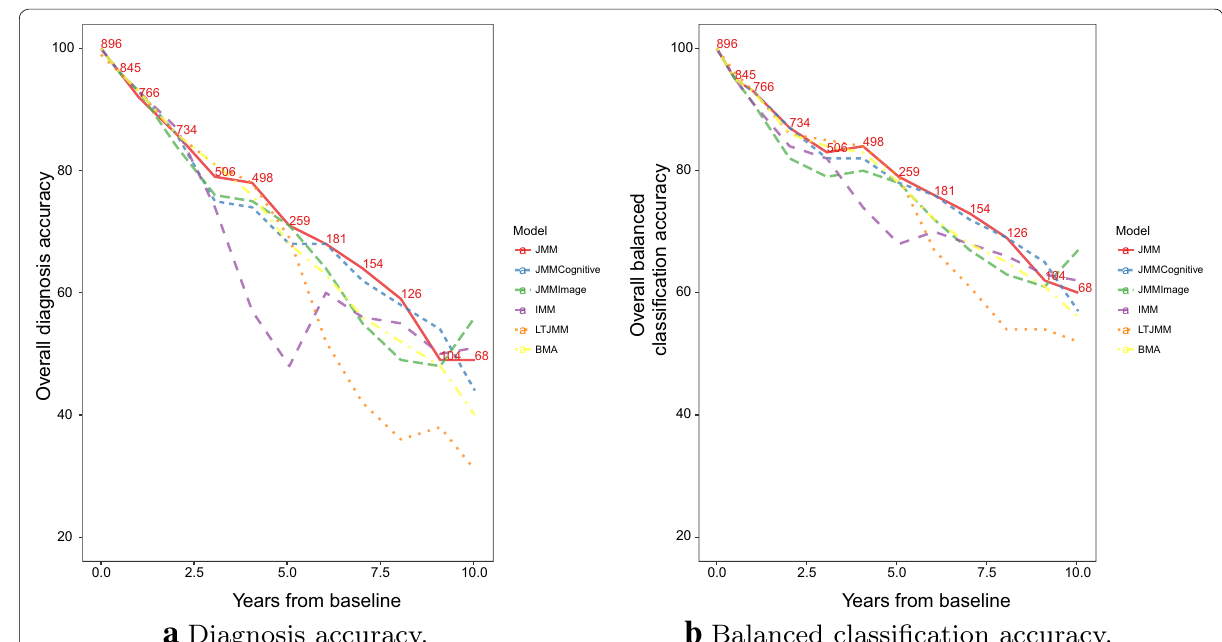
Fig. 6 Comparison of performance metrics for categorical diagnosis. Note that only the LTJMM did not include baseline diagnosis as a covariate. The numbers on the graph represent the number of subjects at each of the time points. IMM Independent mixed-effects model, JMM joint mixed-effects model, LTJMM latent-time joint mixed-effects model, BMA Bayesian model averaging, JMMCognitive JMM fitted to cognitive and function outcomes only, JMMImage JMM fitted to imaging markers